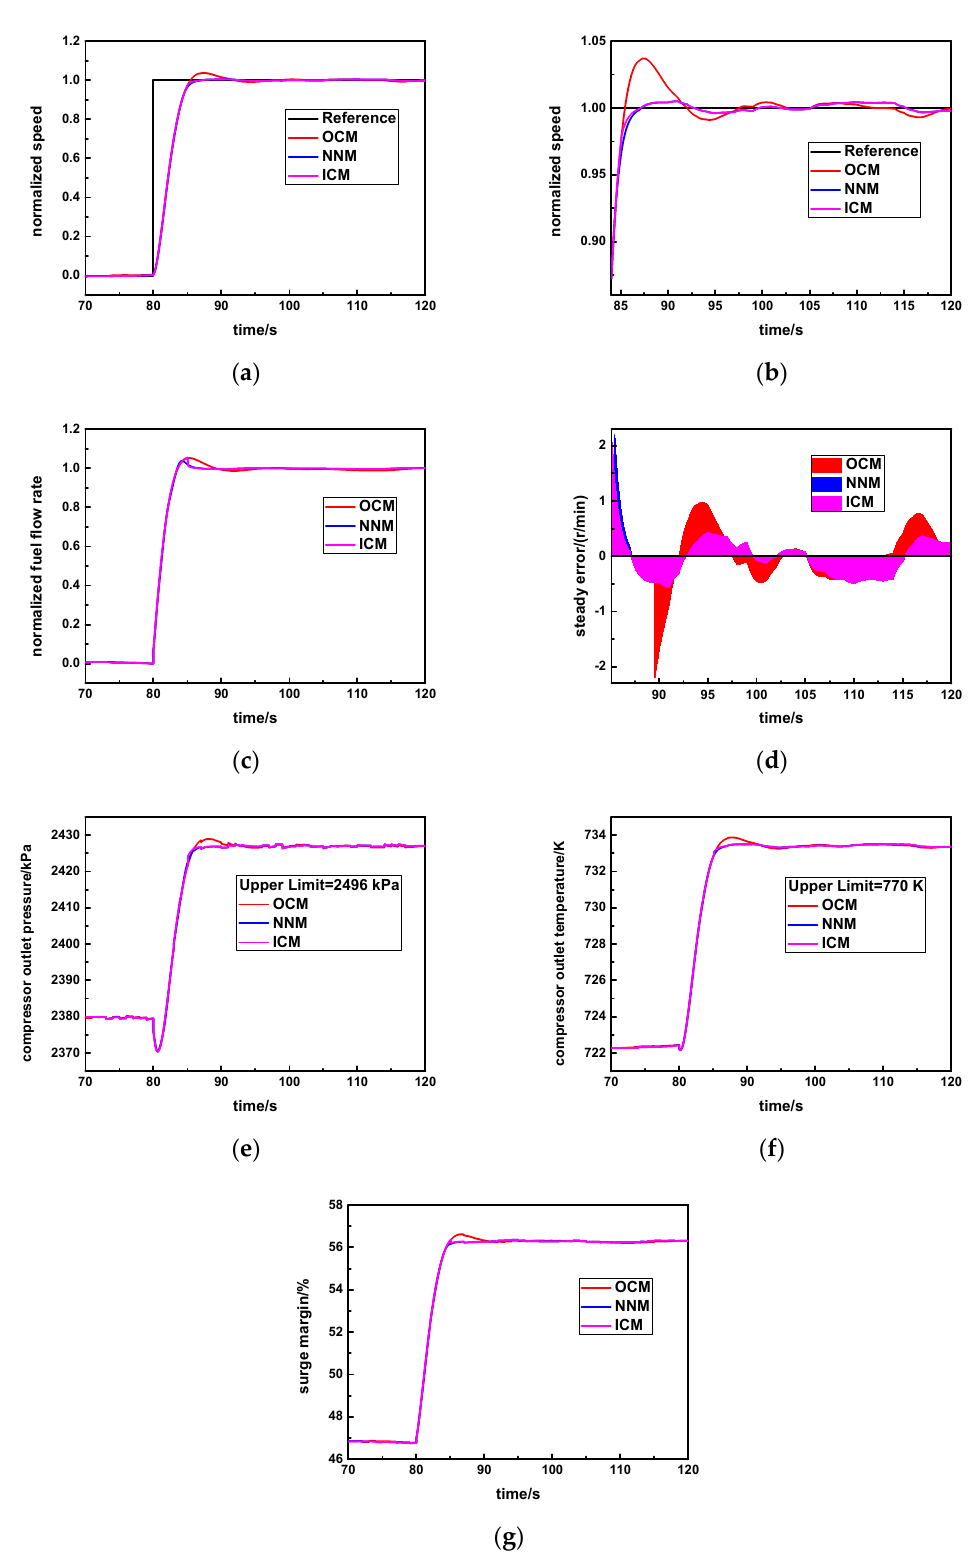
Figure 12. Related parameters distribution of fourth step test. ( a ) Speed response curve, ( b ) Locally enlarged speed curve, ( c ) Fuel flow rate, ( d ) Steady error, ( e ) Compressor outlet pressure, ( f ) Com- pressor outlet temperature, ( g ) Surge margin of compressor.